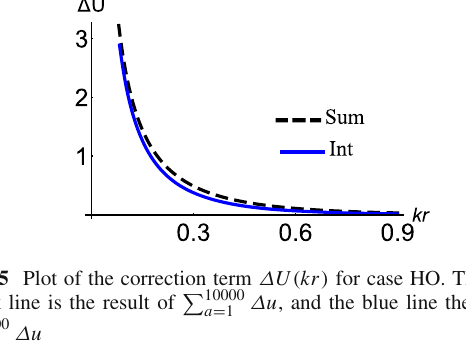
(cid:16) 10000 Δ u , and the blue line the result of a = 1